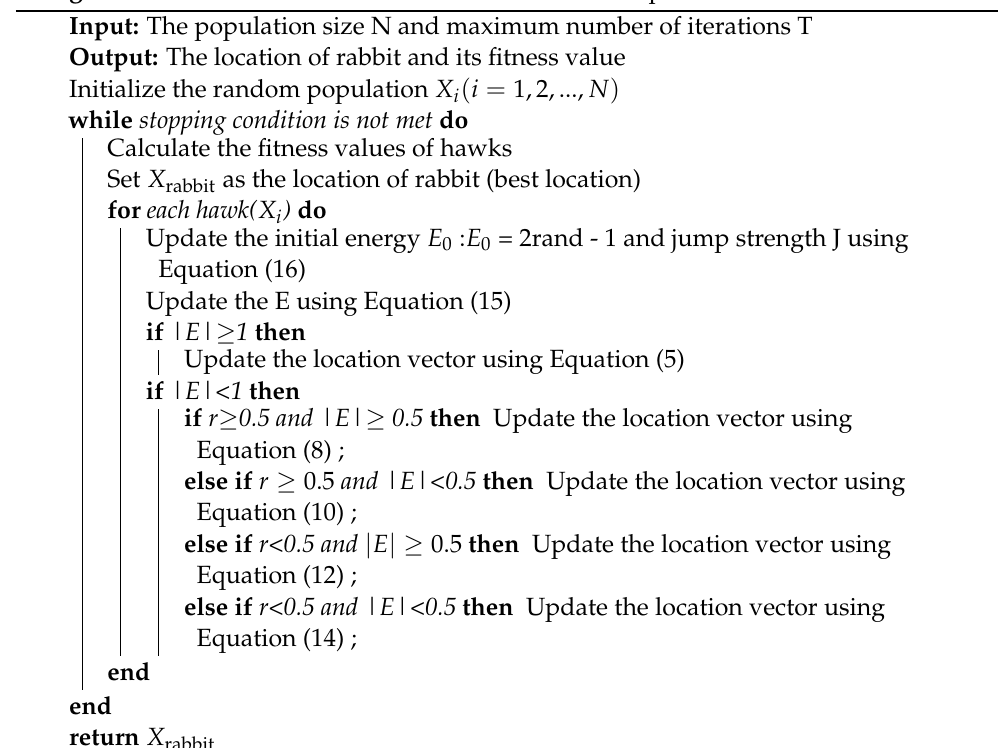
Algorithm 2: Pseudo code of Elevated Harris Hawks